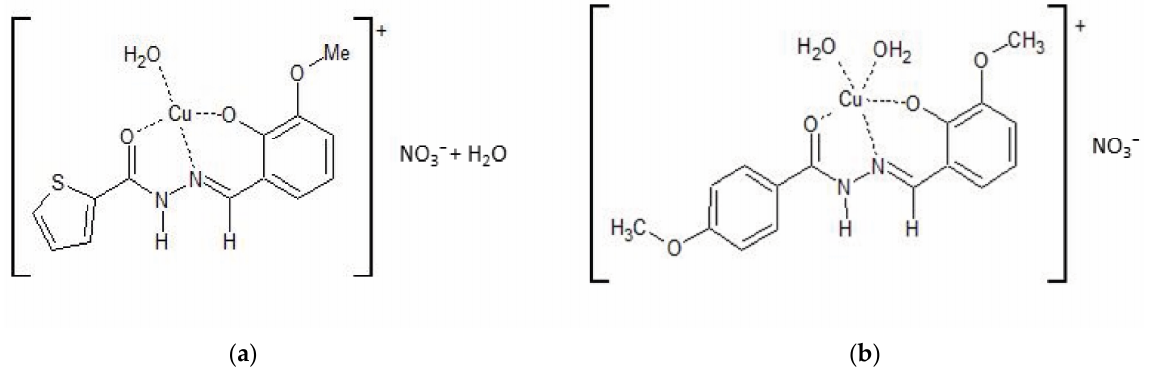
Figure 1. Schematic representation of ( a ) CuHL1 and ( b ) CuHL2. The corresponding hydrazone (H 2 L1: 2-acetylthiophene-2-hydroxy-3-methoxybenzoh ydrazone and H 2 L2: 2-acetyl-4-methoxyphenyl-2-hydroxy-3-methoxybenzohydrazone) coordinates to the metal as a monoanionic ligand (HL − ), by deprotonation of the phenolic oxygen, through the ONO chelating system. The coordination sphere of CuHL1 and CuHL2 is completed with one and two water molecules, respectively, according to the previously reported crystallographic